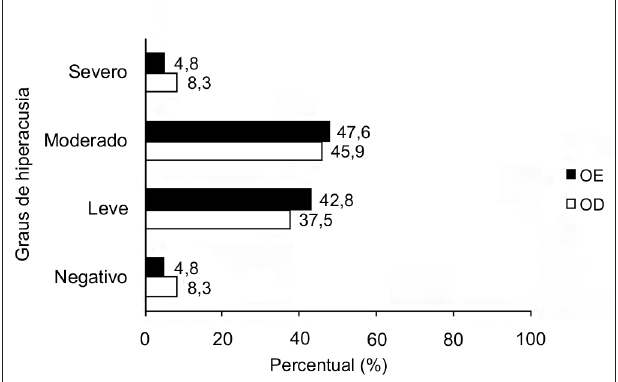
Figura 3. Graus de hiperacusia segundo o LDL nas orelhas direita e esquerda, em indivíduos normo-ouvintes com queixas de hiperacusia e zumbido. OD - orelha direita. OE - orelha esquerda.